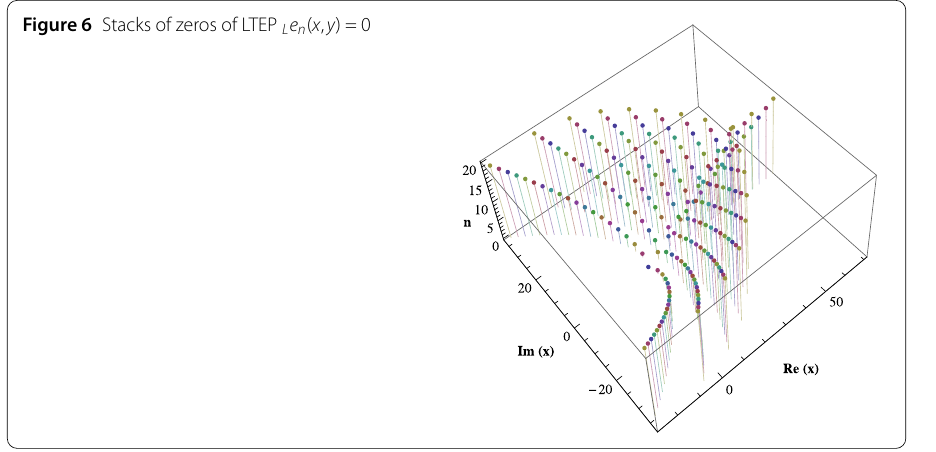
Figure 6 Stacks of zeros of LTEP L e n ( x , y ) =